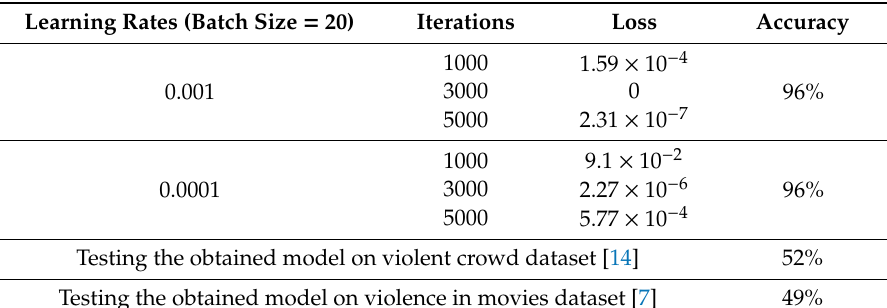
Table 5. Classification accuracies of proposed method on hockey fight dataset [7].